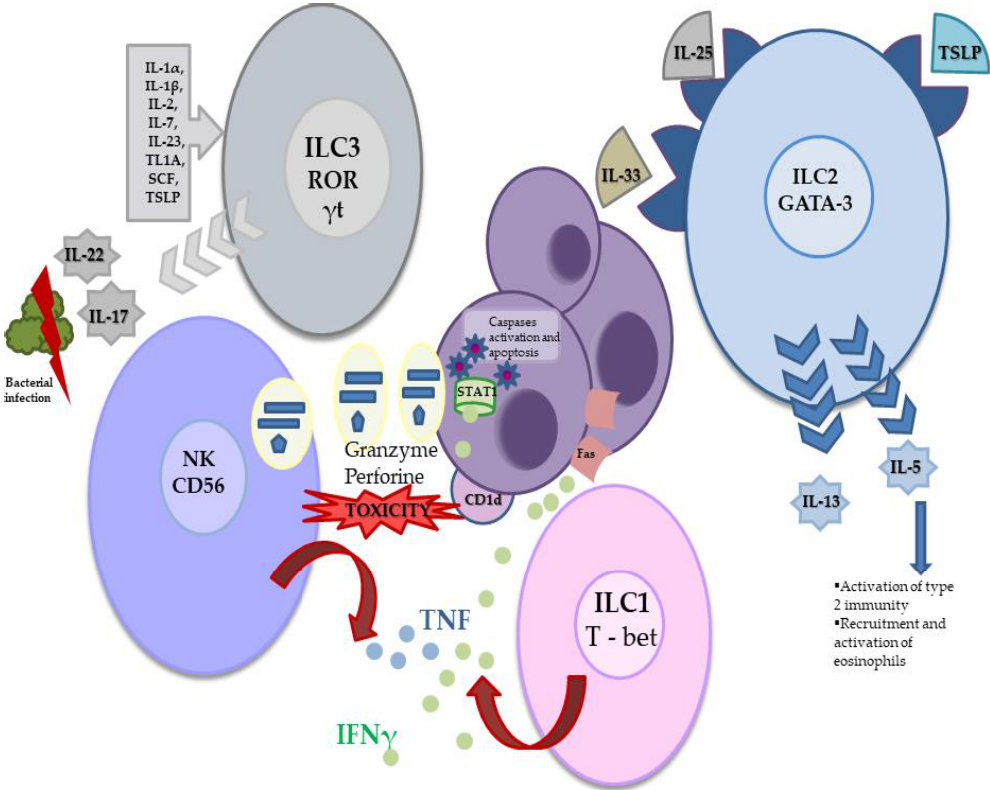
Figure 2. The role of ILCs in MM pathogenesis. ROR γ t—retinoic-acid-receptor-related orphan nuclear receptor γ ; SCF— stem cell factor; TL1A — tumour necrosis factor-like cytokine 1A; TSLP — thymic stromal lymphopoietin.